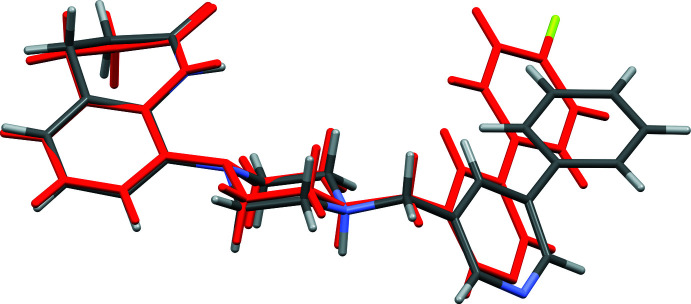
A view of the structural overlap of the cations of salts I·HCl and II·HCl; r.m.s. deviation 0.125 Å (Mercury; Macrae et al., 2020 ▸). The structure of the II·HCl cation is given in red with the F atom in yellow (see also supplementary figure S1; Ullah & Altaf, 2014 ▸).